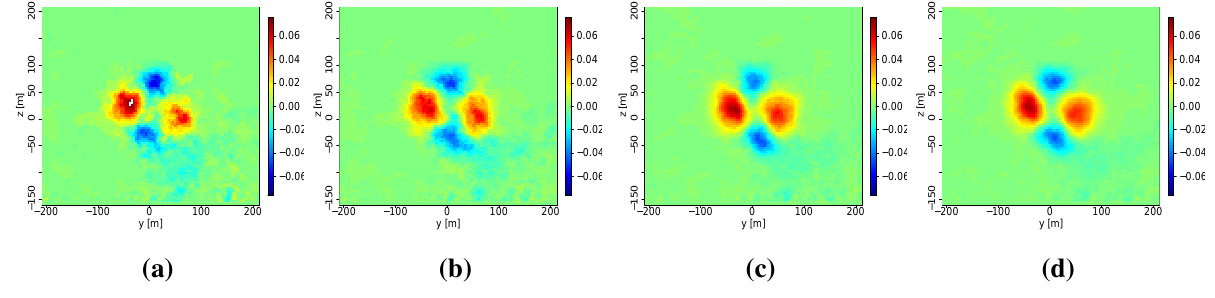
Figure B2. Fourth POD mode estimated using different numbers of snapshots: ( a ) 1000; ( b ) 2000; ( c ) 6000; ( d )